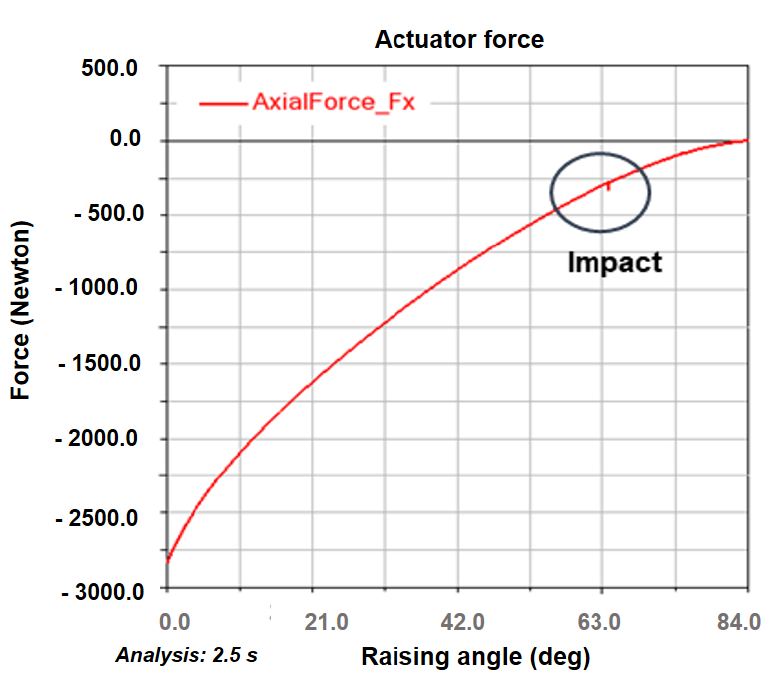
Figure 9. Dynamic simulation of the system (raising time 2.5 s and constant speed of the actuator). It is noteworthy to mention that the diagram has a little jitter at 63.5 degrees when the pin comes into contact with the hook and raises it. In Figure 10, the 3D model used for this simulation is